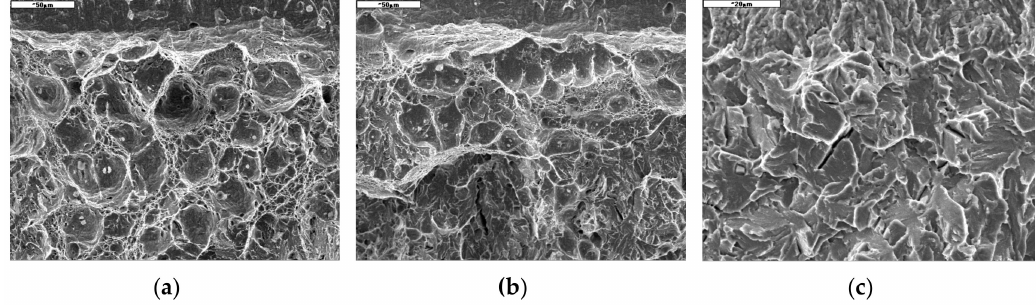
Figure 9. Types of cracking of AHSS S960QCat di ff erent temperatures: ( a ) T = 20 ◦ C; ( b ) T = − 50 ◦ C; ( c ) T = − 120 ◦